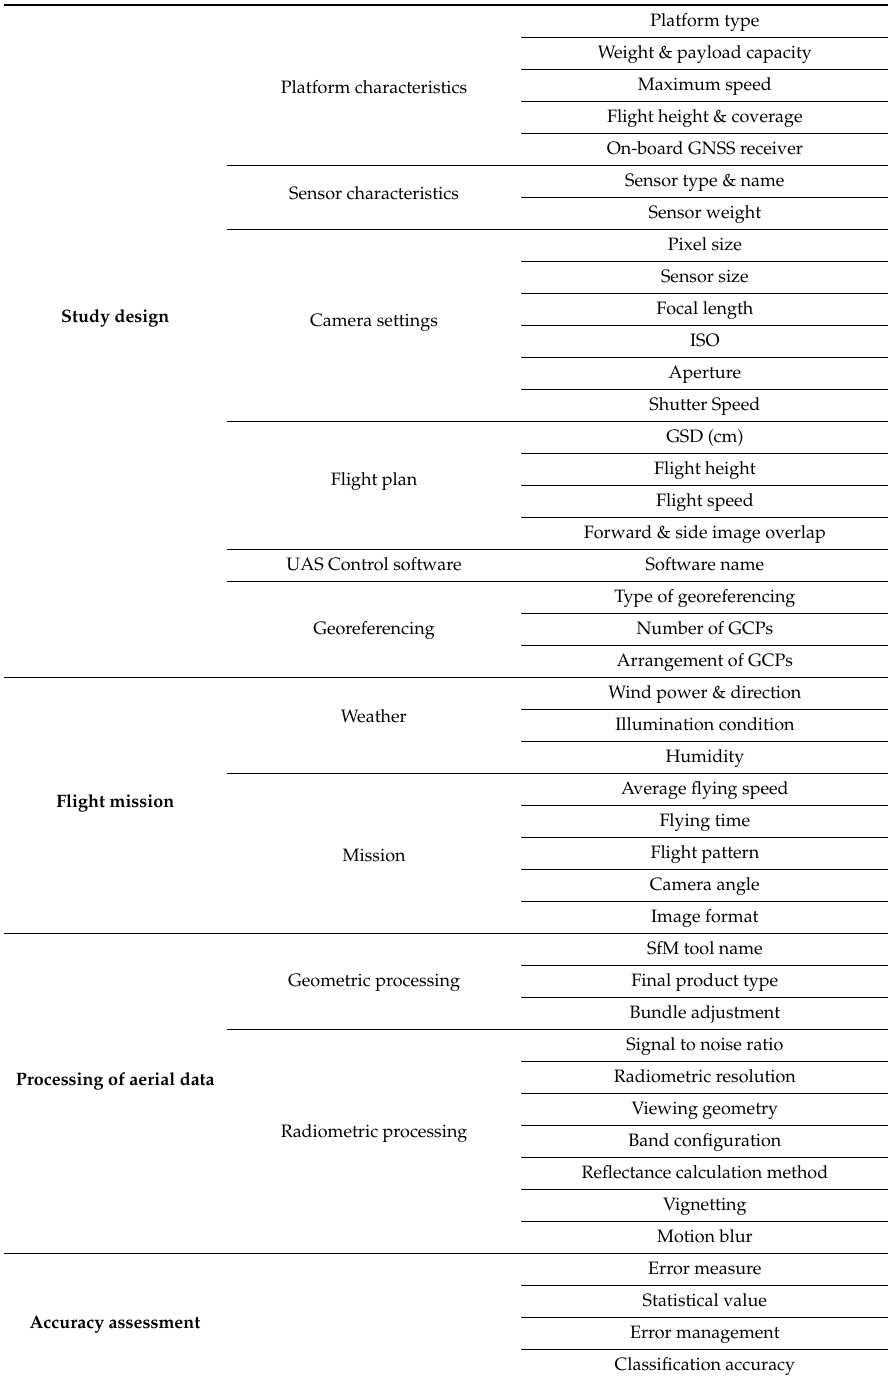
Table A2. Metadata associated with each